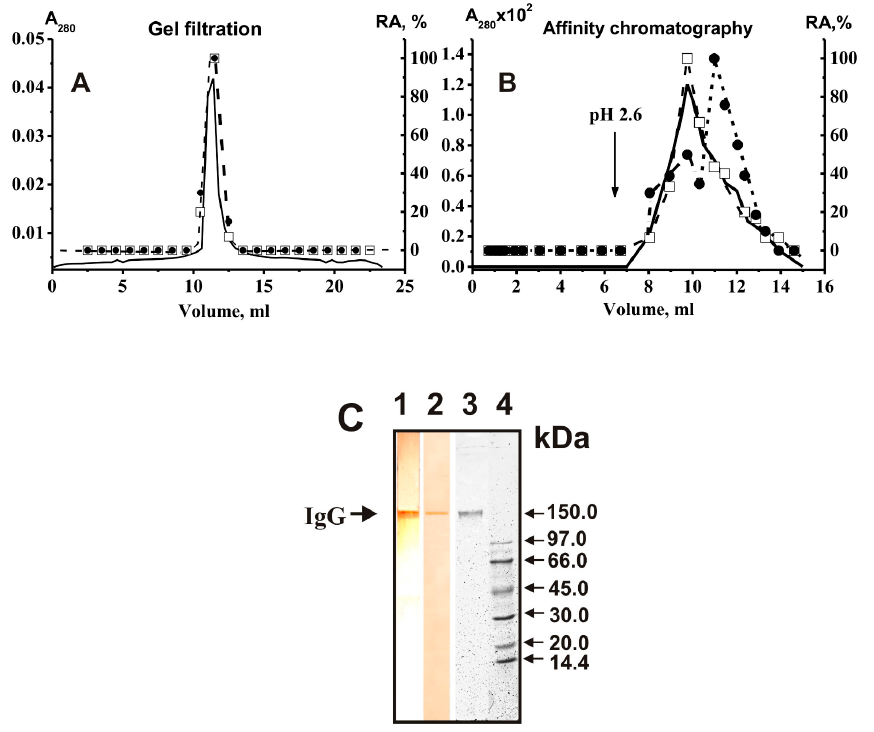
Figure 3. Gel filtration of rat IgGs on a Superdex 200 column in an acidic buffer (pH 2.6) after Ab incubation with this buffer ( A ) and affinity chromatography of IgGs on Sepharose bearing immobi- lized rabbit IgGs against rat IgGs ( B ): ( __ ), absorbance at 280 nm; the relative activity of IgGs (RA, %) was measured using DAB in the presence ( • ) and the absence ( □ ) of H 2 O 2 . In situ SDS-PAGE analysis of rat IgGs peroxidase and oxidoreductase activities ( C ). The peroxidase activity was revealed by incubation of longitudinal gel slices in the reaction mixture containing DAB, 10 mM H 2 O 2 , and 5 mM CuCl 2 (lane 1, C ), while peroxide-independent oxidoreductase activity—incubation without H 2 O 2 (lane 2, C ). An additional control longitudinal band of the same gel was stained with Coomassie R250 to reveal IgG positions (lane 3, C ). Arrows show the positions of proteins’ molecular mass markers (lane 4, C ) [171].